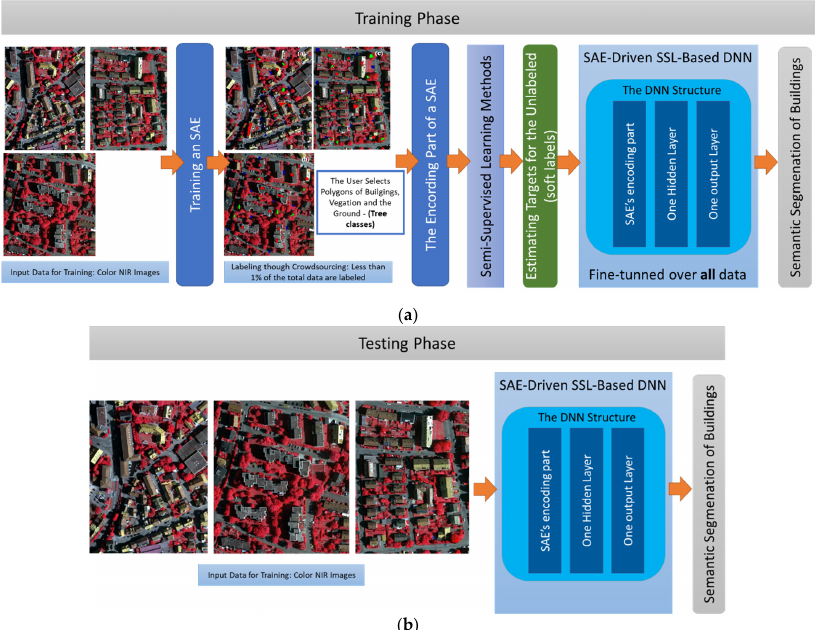
Figure 1. A block diagram of the proposed combined Stack Auto-encoder (SAE)-driven and Semi-Supervised learning (SSL)-based Deep Neural Network (DNN) structure for semantic segmentation of buildings from Near Infrared (NIR) satellite images. ( a ) The training phase. ( b ) The testing phase.